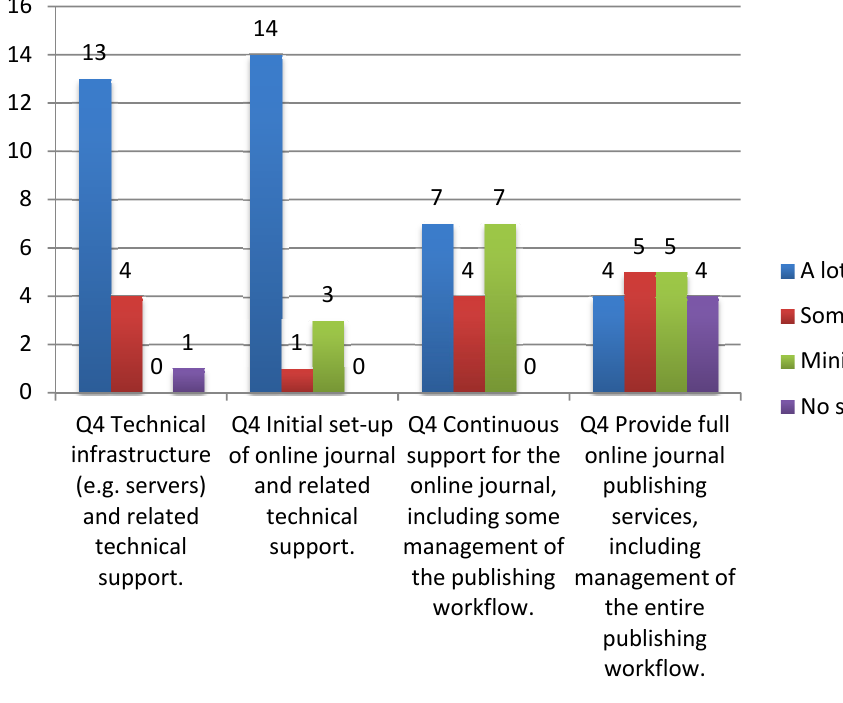
Figure 3. Full Time Equivalent (FTE) number involved in journal hosting